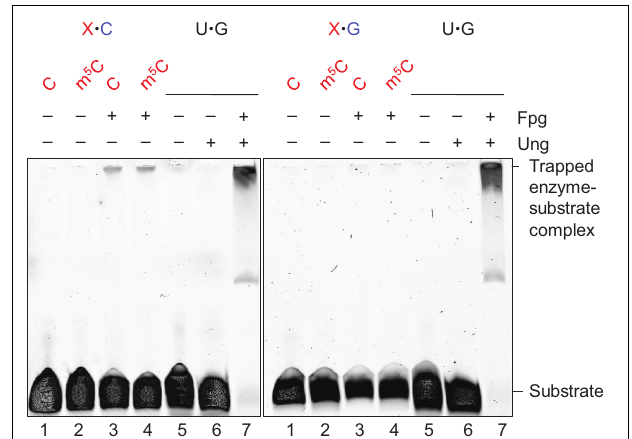
FIGURE 2 | Schiff base trapping analysis of Fpg protein. DNA substrate (1 pmol) with either X · C (left panel) or X · G (right panel) base pair, alone as a negative control (lanes 1 and 2), or together with Fpg (10 pmol; lanes 3 and 4), was incubated with 50 mM NaBH 4 in reaction buffer at 37 ◦ C for 1 h (final volume, 10 µ L). U · G-DNA (30 nt; 1 pmol) incubated alone (lane 5), with Ung (10 pmol; lane 6), or with Ung and Fpg (10 pmol each; lane 7), was used as a negative and positive control for active Ung and Fpg, respectively, Ung converting U · G-DNA into AP-DNA to be trapped by Fpg. The trapped